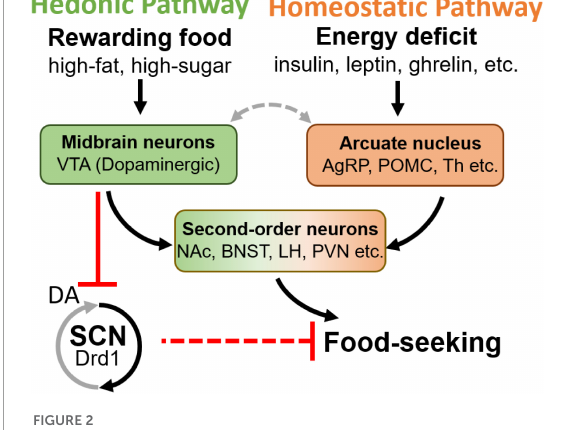
FIGURE2 Schematic diagram of hedonic and homeostatic feeding pathways, and the second-order brain areas integrating both inputs. Notably, the DA in the SCN causes an inhibitory effect (Grippo et al., 2020), although Drd1 is a Gq coupled receptor which normally excites the neuron, potentially due to the GABAergic local projection within the SCN. VTA, ventral tegmental area; AgRP, agouti-related peptide; POMC, pro-opiomelanocortin; NAc, nucleus accumbens; BNST, bed nucleus of the stria terminalis; LH, lateral hypothalamus; PVN, paraventricular nucleus of hypothalamus; SCN, suprachiasmatic nucleus; Drd1, D1 dopamine receptor; Th, tyrosine